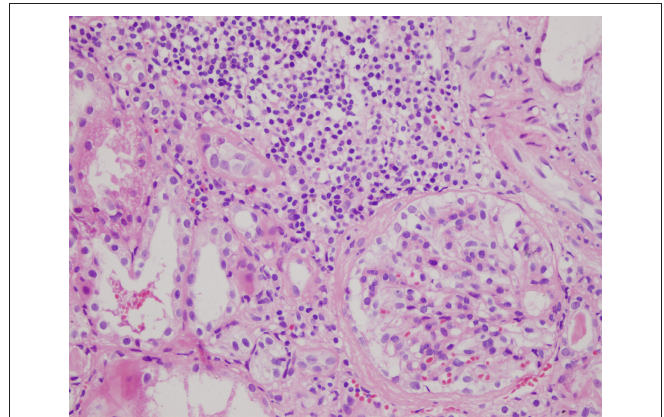
Figure 1. Kidney biopsy which presents glomerular mesangial cellular proliferation, enhanced mesangial matrix, and periglomerular fibrosis with nearby tubular inflammatory infiltration, H&E: × 200.